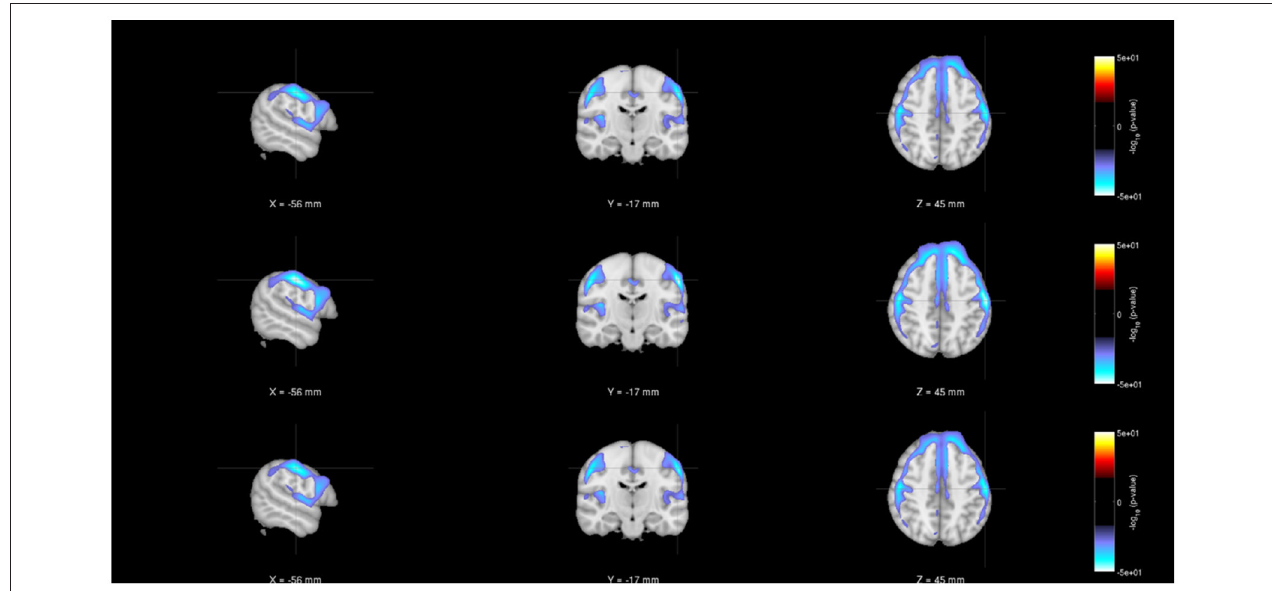
FIGURE 4 | Rendered images of voxel-wise significance values ( − log 10 p -value × sign( t )) for the covariate “Age” from pooled regression (Top) and single-shot regression (Center) , and multi-shot regression (Bottom) overlaid on MNI average template. One could see that the regions with expected gray matter decrease as age increases are similar from all kinds of regression. Although the single-shot regression uses fewer covariates, the similarity of the rendered images with those of pooled regression or multi-shot regression indicate the relative weight or orientation of the corresponding β coefficient will be similar to those from pooled/multi-shot regression.